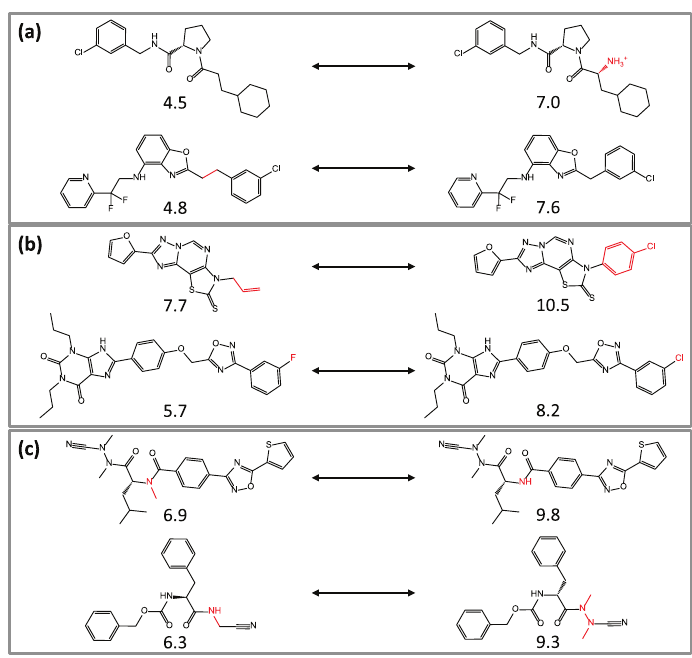
Figure 1. MMP-cliffs. Six representative MMP-cliffs for three targets belonging to different target families are shown; ( a ) muscarinic acetylcholine receptor M3, ( b ) serine/threonine-protein kinase c-TAK1, ( c ) matrix metalloproteinase-2. The pK provided and the structural differences between cliff-forming compounds are highlighted in